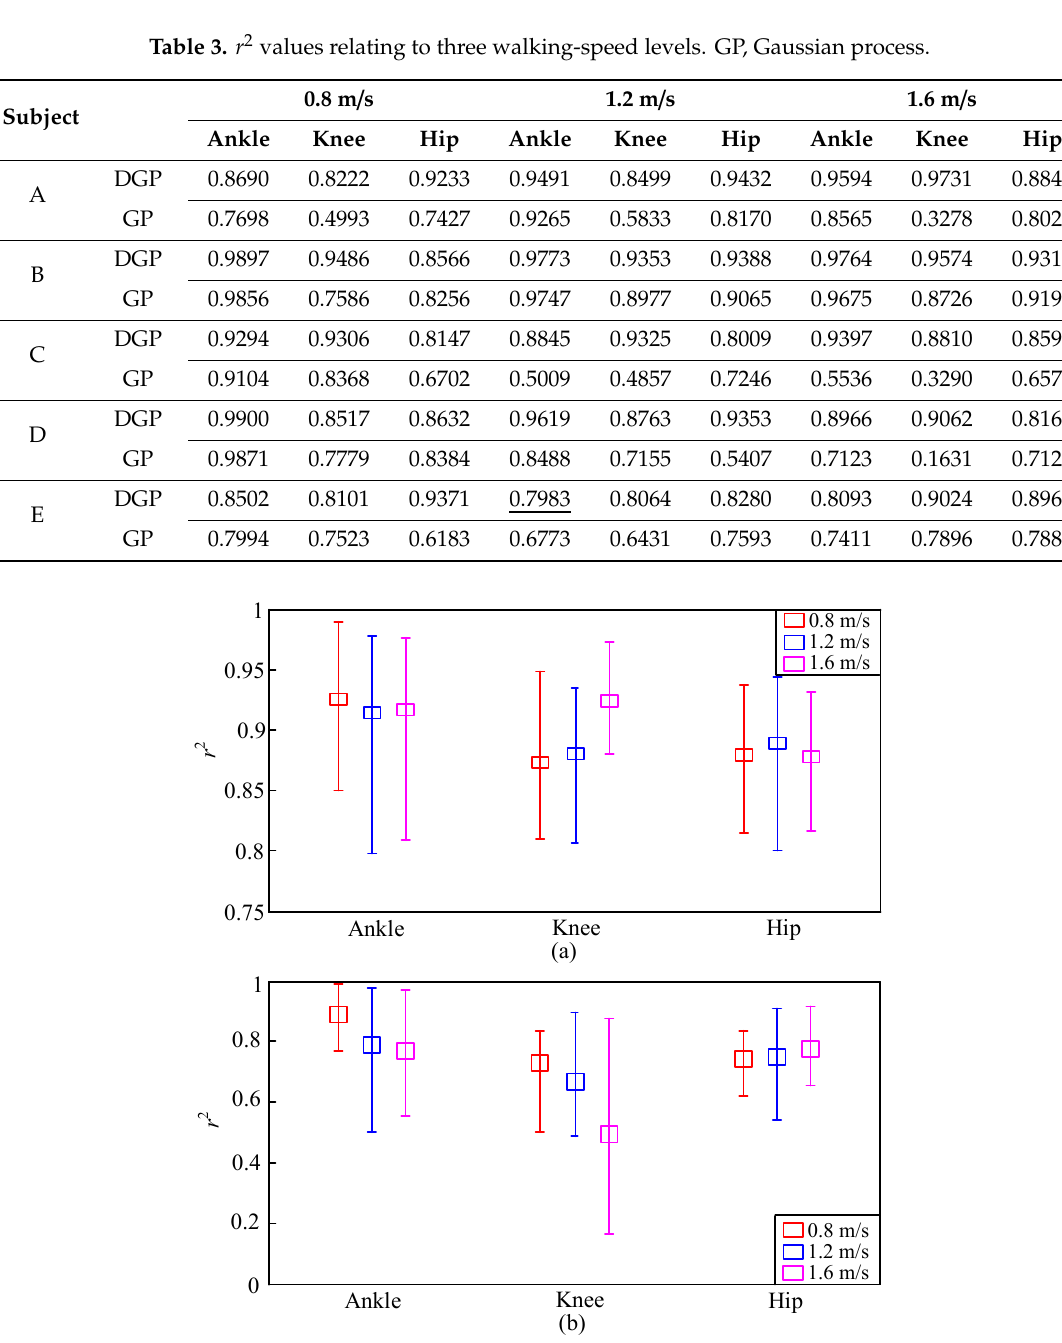
Table 3. r 2 values relating to three walking-speed levels. GP, Gaussian process.